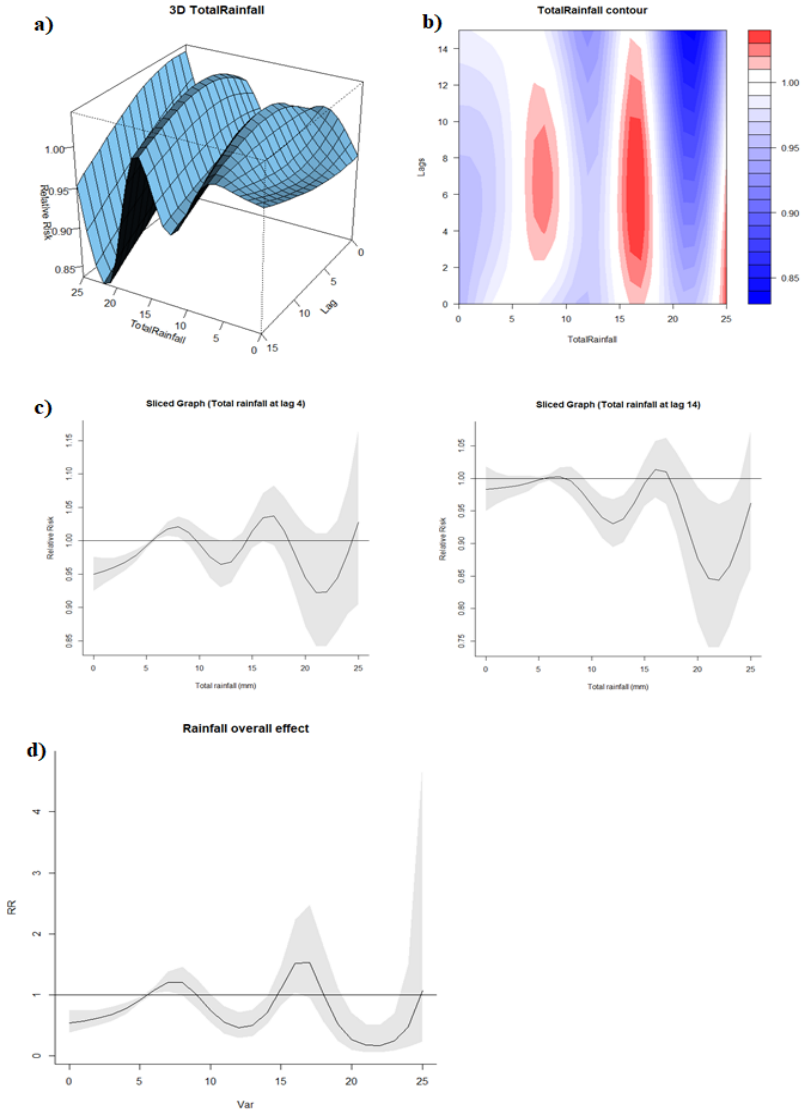
Figure 4. ( a ) 3D graph of rainfall-lag-dengue association; ( b ) contour graph of rainfall-lag-dengue association; ( c ) sliced graph of rainfall-dengue association at lag 4 and 11; ( d ) overall effect graph of rainfall-dengue association.